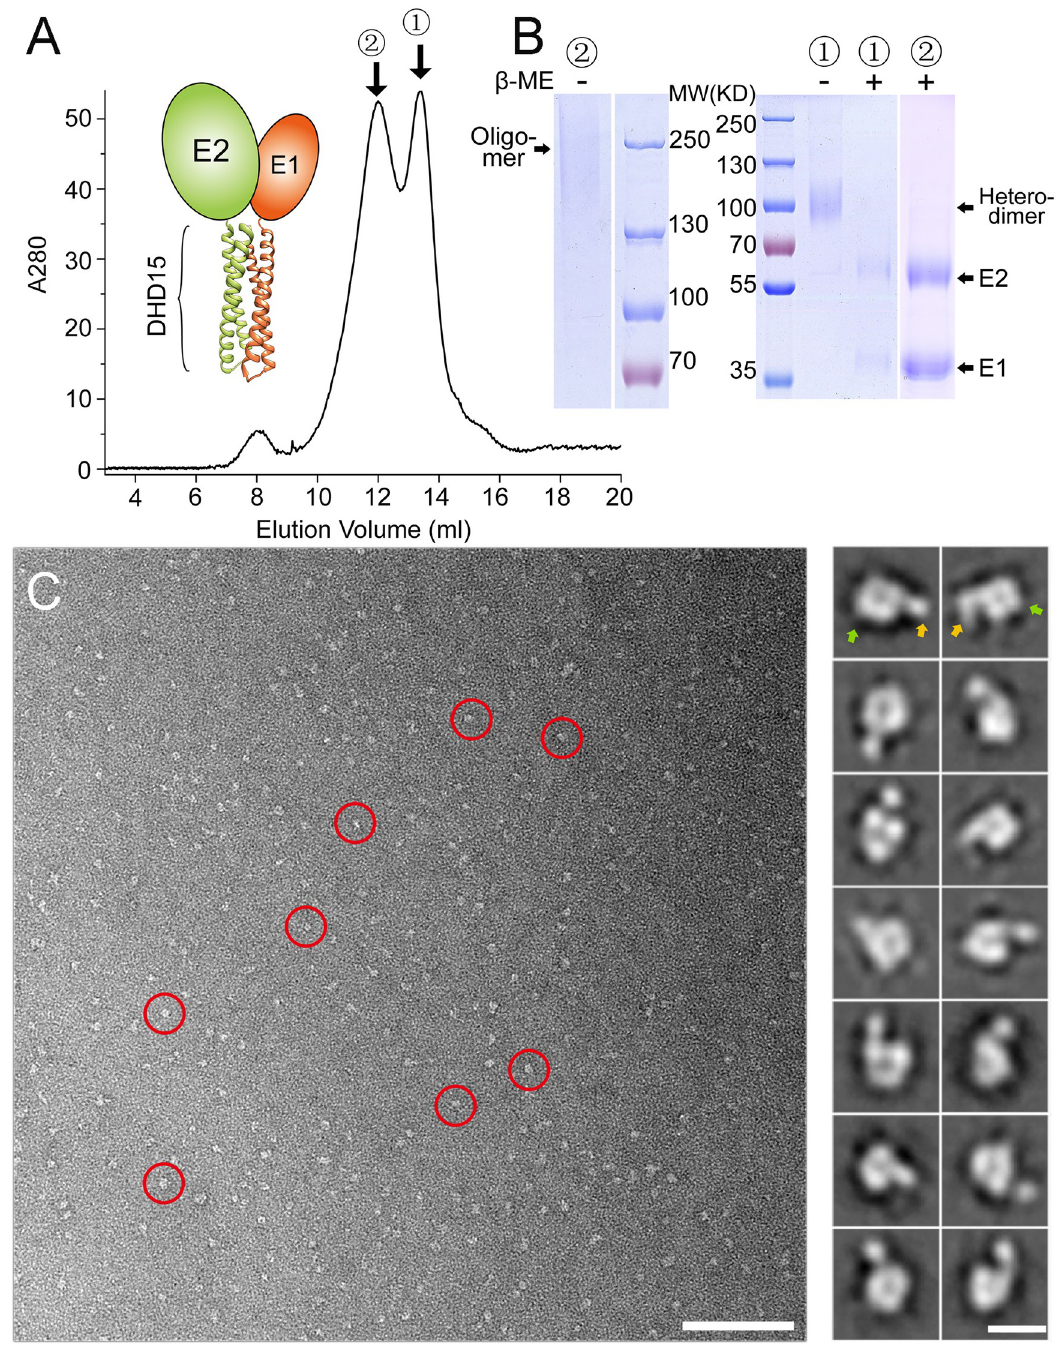
Fig 2. Expression of HCV E1E2 using a de novo designed heterodimeric tag DHD15 in insect cells. (A) Schematic representation of the HCV E1E2 heterodimer with a de novo designed tag DHD15 and the SEC profile of the purified E1E2-DHD15 expressed in insect cells. The heterodimeric and oligomeric peaks of E1E2-DHD15 are labeled as 1 and 2, respectively. (B) SDS-PAGE of the purified E1E2-DHD15 under reducing and non-reducing conditions for the two peaks shown in (A). (C) A negative staining EM image showing the heterodimeric E1E2-DHD15 particles (left; red circles; bar, 100 nm). The representative 2D averaging classes are also shown (right; bar, 10 nm). The head and the tail regions are indicated by green and orange arrows, respectively.